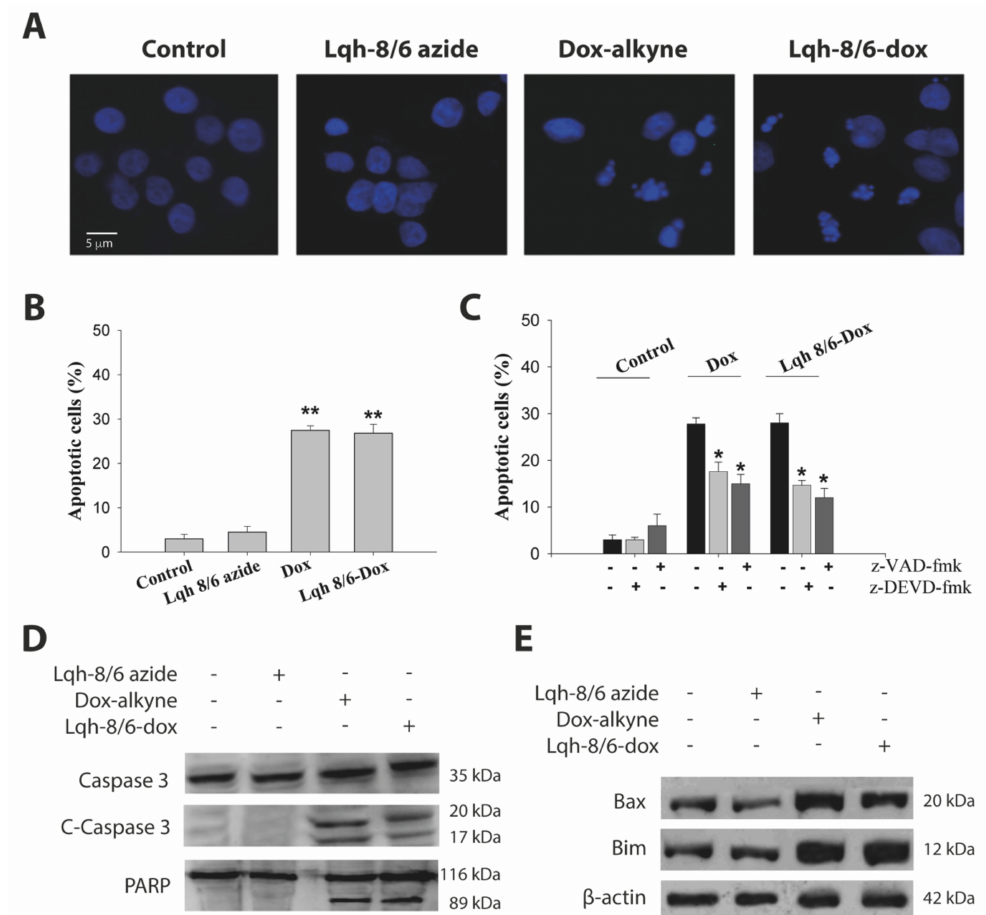
Figure 7. Lqh-8/6-doxorubicin induces U-87 cell apoptosis. ( A ) Hoechst-stained U-87 cells showing morphological changes induced in the cell nuclei. Apoptotic cells show condensed and fragmented nuclei. Concentration: 10 µ M (Lqh-8/6-azide, doxorubicin-alkyne or Lqh-8/6-doxorubicin). ( B ) Per- centage of apoptotic cells induced by the various treatments for 24 h at 10 µ M. **, p ≤ 0.01. ( C ) Effects of a broad-spectrum caspase inhibitor, z-VAD-fmk, and a caspase-3/-7-specific inhibitor, z-DEVD-fmk, on the percentage of apoptotic cells for the different treatments. *, p ≤ 0.05. ( D ) Caspase 3 and PARP cleavage induced by doxorubicin-alkyne and Lqh-8/6-doxorubicin. Total proteins were extracted and detected by Western blot analyses using antibodies against C-Caspase-3 and PARP. ( E ) Up-regulation of Bax and Bim levels in U-87 cells by 10 µ M of doxorubicin-alkyne or